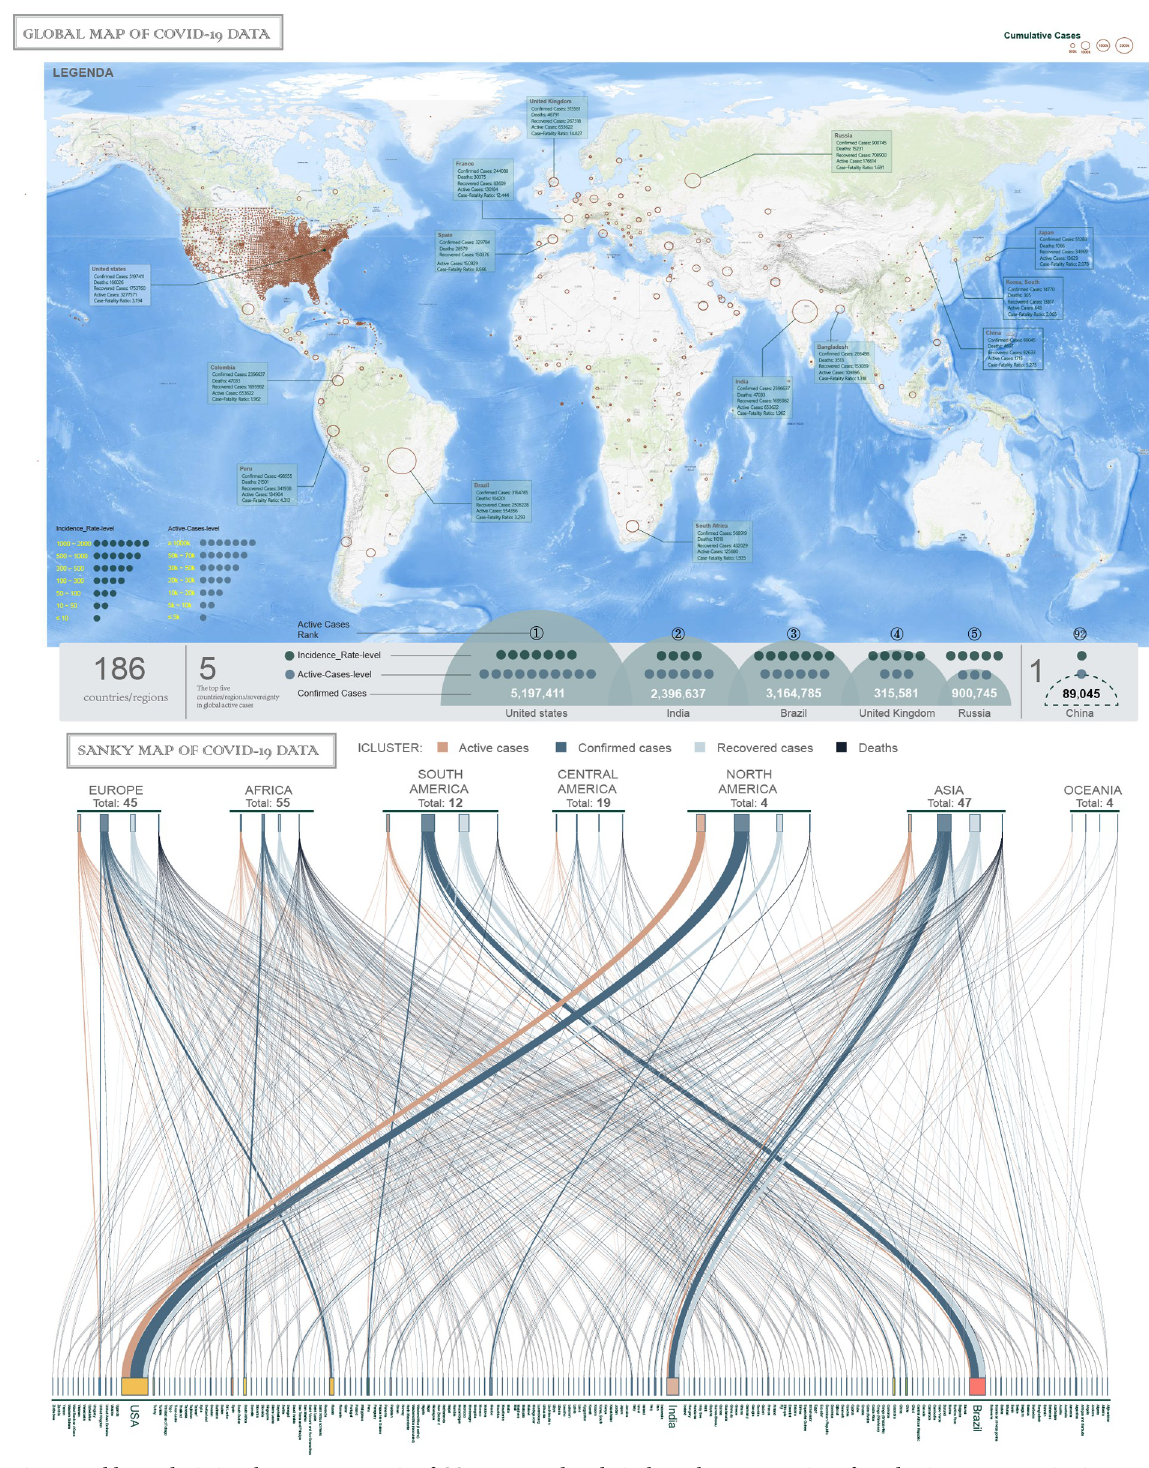
Fig 1. World map depicting the current scenario of COVID-19 and analysis through reconstruction of pandemic reprogramming in pseudospace and pseudotime manners. (A) Shown are 186 countries or regions with reported confirmed cases of COVID-19 as of August 12, 2020. Different colors indicate different WHO designated geographical regions with the number of active cases, and the diameter of the brown circle reflects the number of confirmed cases. The number of droplets just indicate the range of incidence-rate or active cases. (B) The WHO region-wise total number of confirmed cases, deaths, recovered cases and active cases are depicted in different color Sanky strips. (Based on data